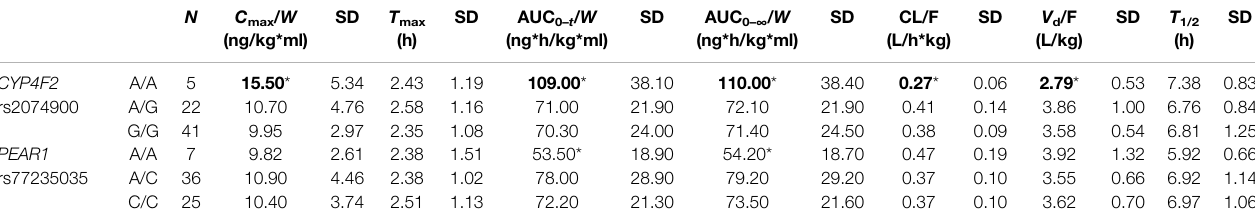
TABLE 3 | Ticagrelor pharmacokinetic parameters based on genotypes with statistical signi fi cance